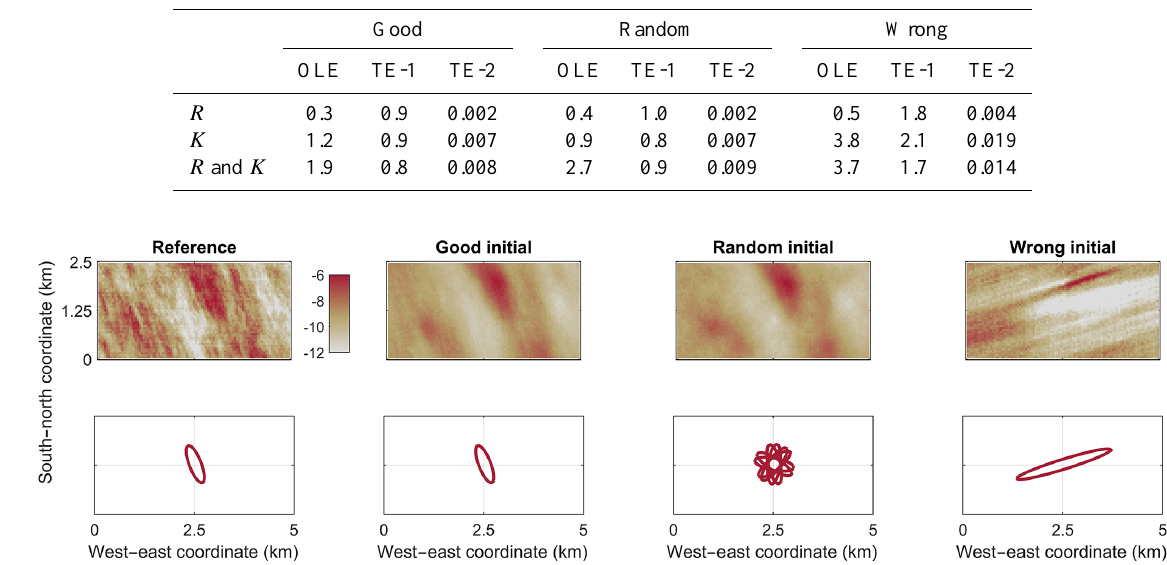
Figure 4. Estimation of stand-alone conductivity. Upper panels show the final ensemble mean after all assimilation steps, and lower plots the covariance function used to generate the initial ensemble. Please note that only a few illustrative examples of the random orientation angle of anisotropy are